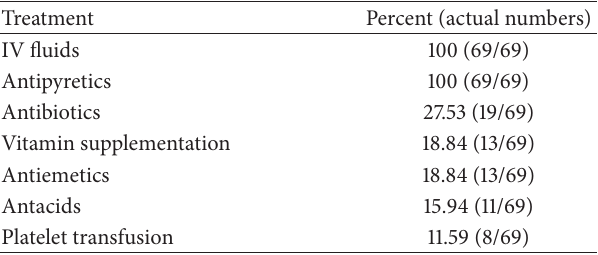
Table 6: Treatment administered to the children with